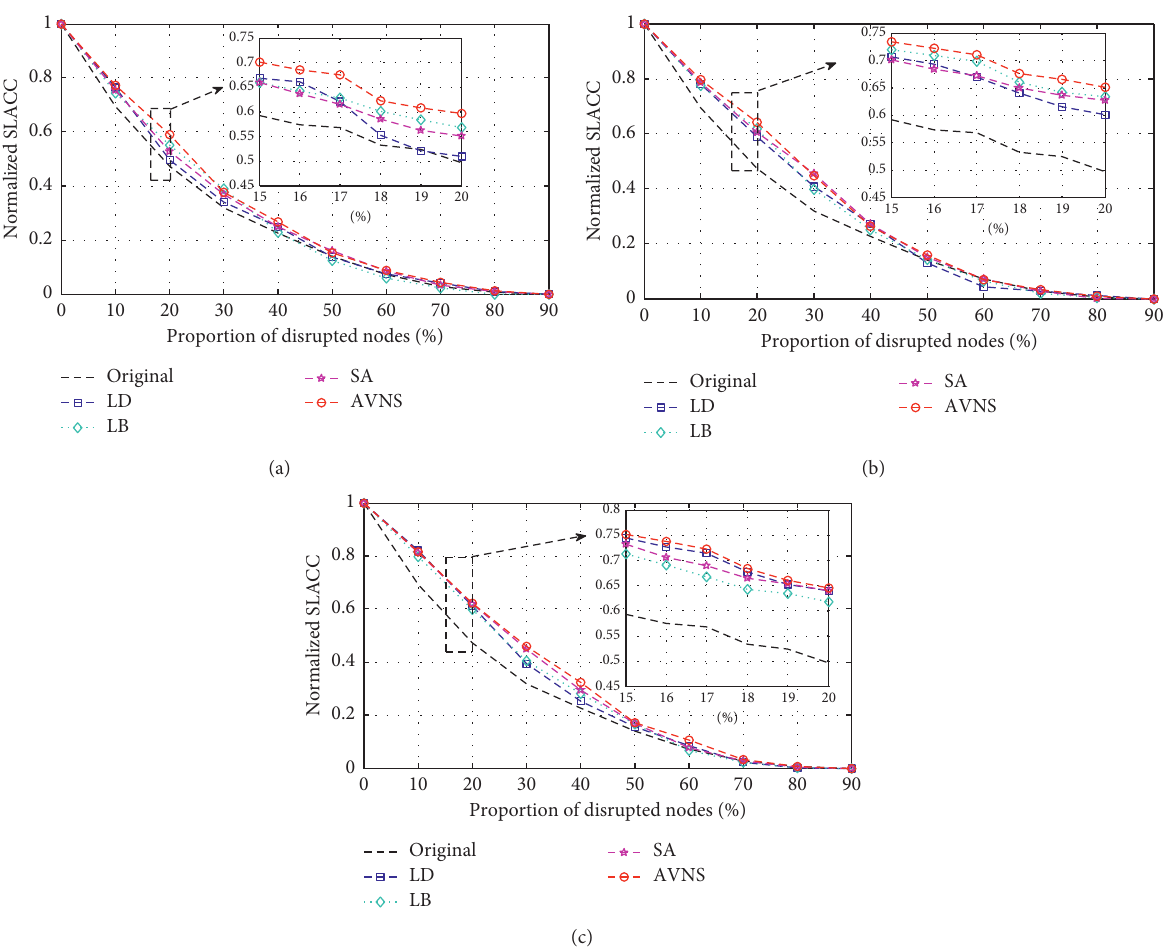
Figure 6: Responses of chain 14 and reconfigured ones facing random disruptions. (a) f